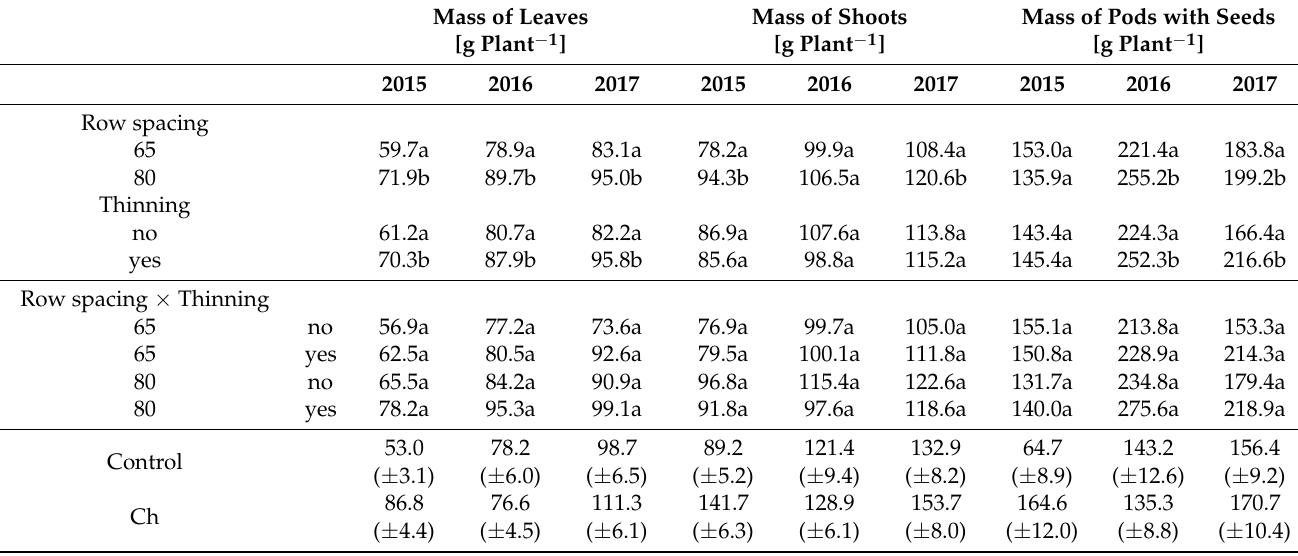
Table 6. Growth parameters of broad beans in the 2015–2017 seasons.